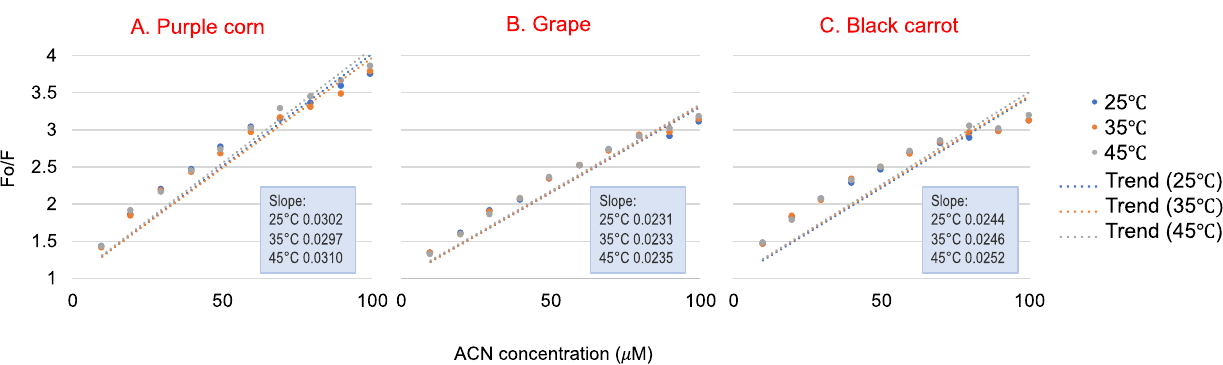
Figure 2. The Stern–Volmer plots for the quenching of whey protein by purple corn ( A ), grape ( B ) and black carrot ( C ) anthocyanin-rich extracts at 25 ◦ C, 35 ◦ C and 45 ◦ C (used for K sv and K q calculations). Data presented are means of three replications. Standard deviations for all data points are less than 0.1. Table 1. The Stern–Volmer constants, quenching constants, binding constants and thermodynamic parameters for purple corn, grape and black carrot anthocyanin-rich extracts binding to whey protein at 25 ◦ C, 35 ◦ C and 45 ◦ C (pH 3). Parameters